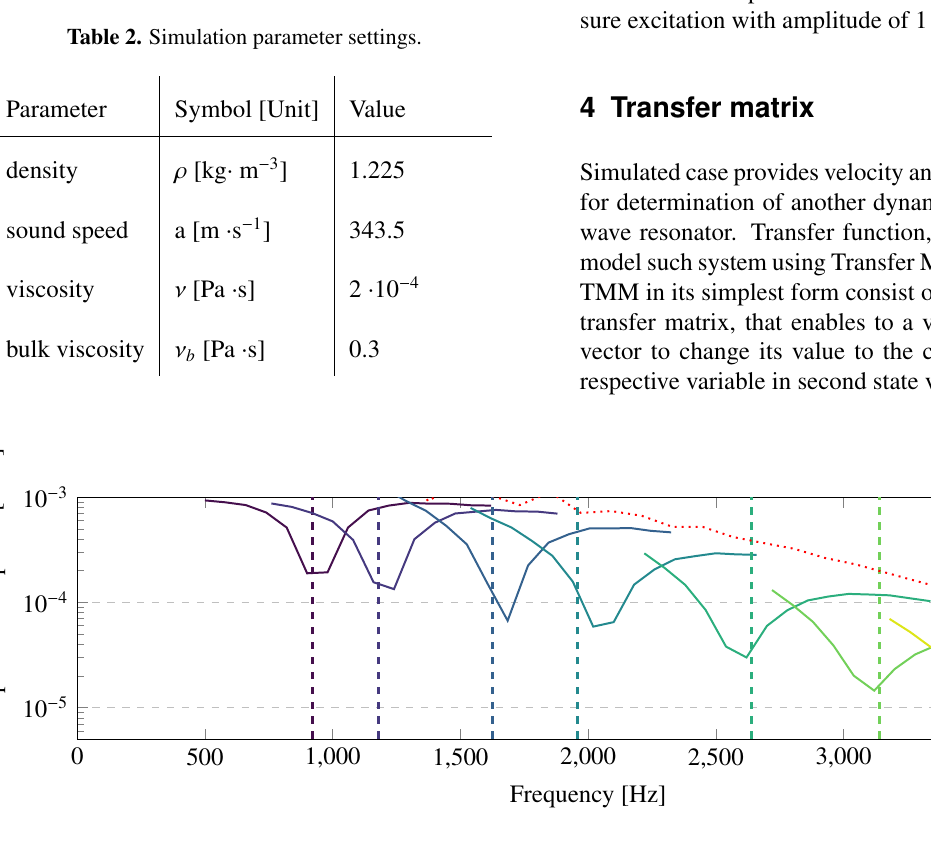
Fig. 5. Natural frequencies of resonators evaluated from experiment (dashed line) compared to computed acoustic pressure response to excitation at opposite end of tube (solid lines). Color pairs are to match same resonator